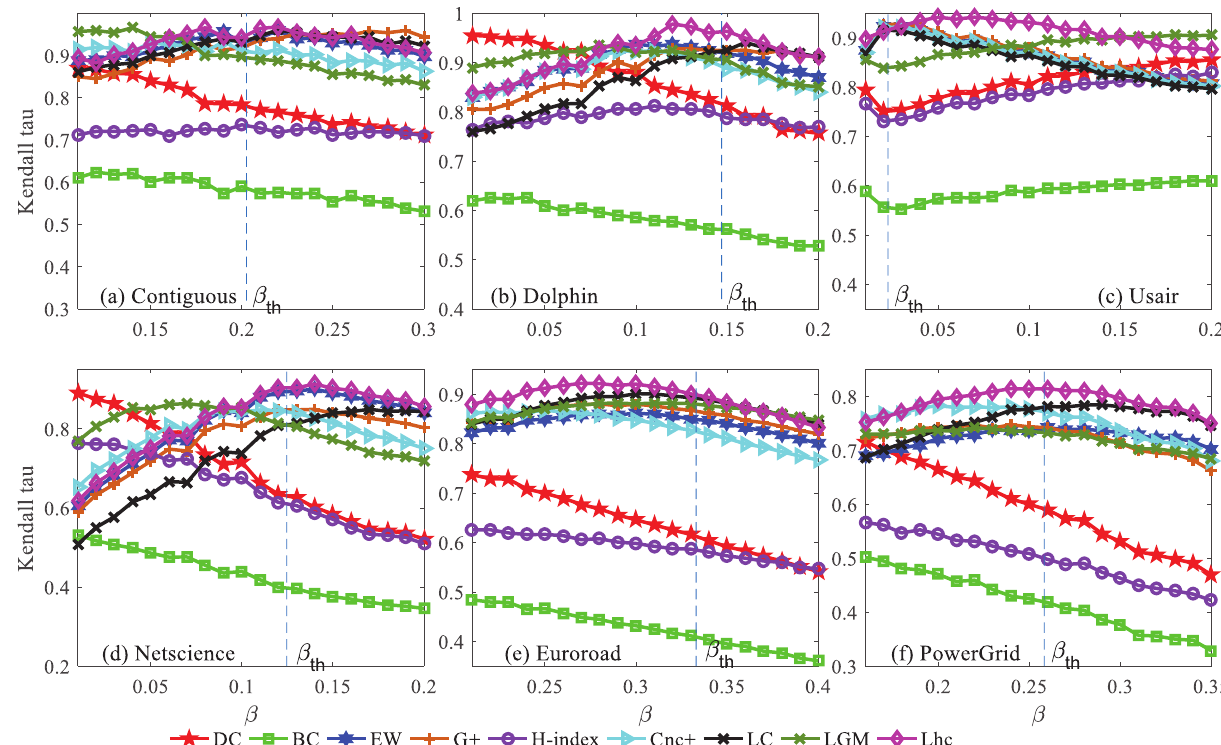
Fig 4. The Kendall’s τ between the ranking list from SIR model and that of the eight measures. (a)-(e): The Kendall’s τ in the network of Contiguous, Dolphin, Usair, Netscience, Euroroad and PowerGrid respectively. Centrality measures are DC, BC, H-index, LC, Cnc + , G + , EW, LGM and Lhc. The dotted line represents the epidemic threshold β th